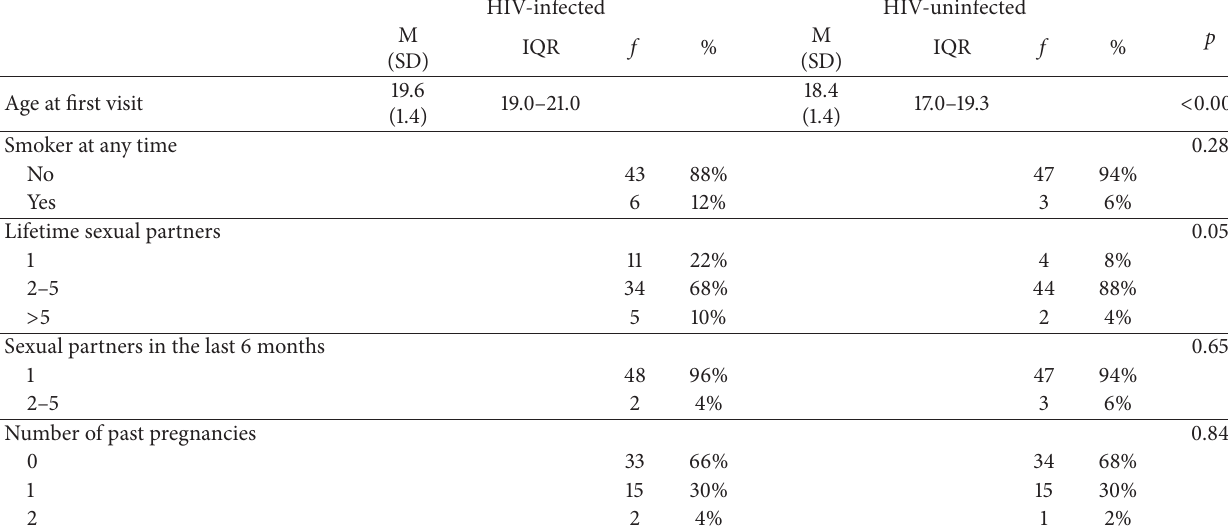
Table 1: Participant demographics and behavioral